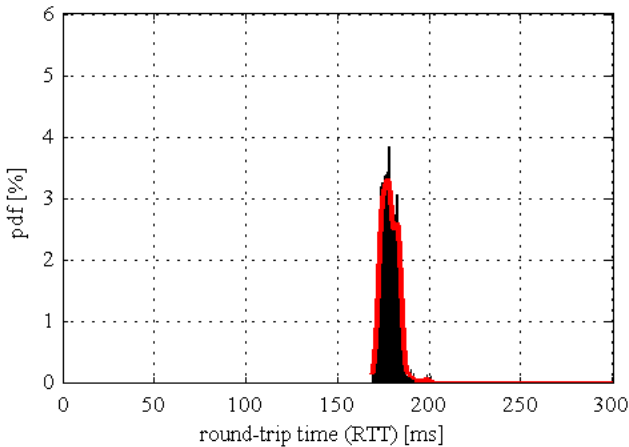
Figure 5. Round-trip time for remote distributed XIL